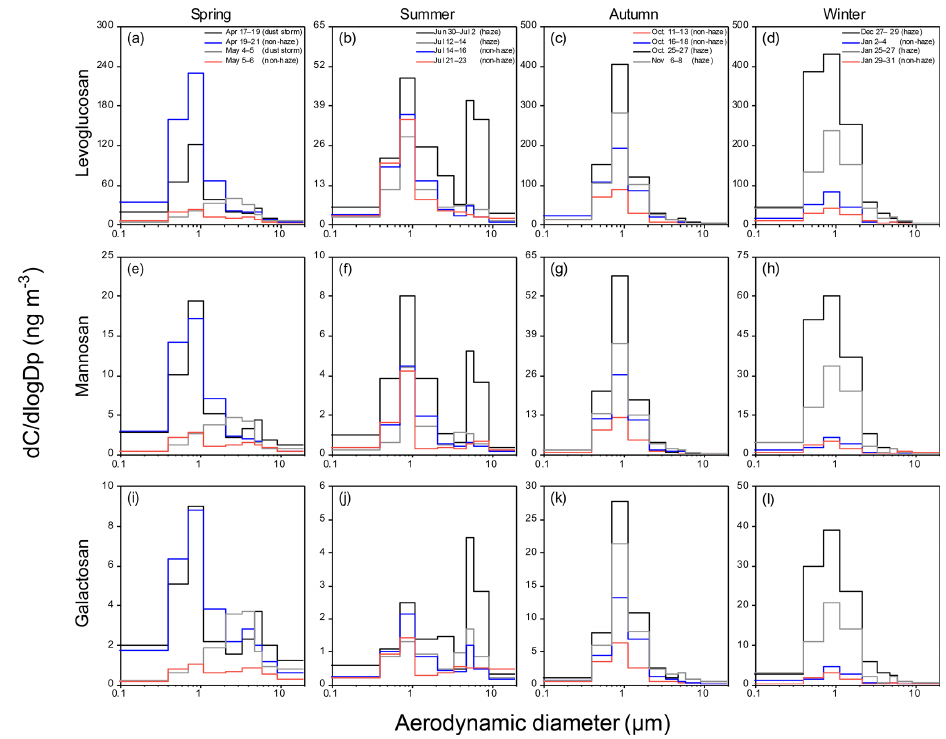
Figure 5. Size distributions of levoglucosan and its isomers, mannosan and galactosan, in urban aerosols in Beijing.